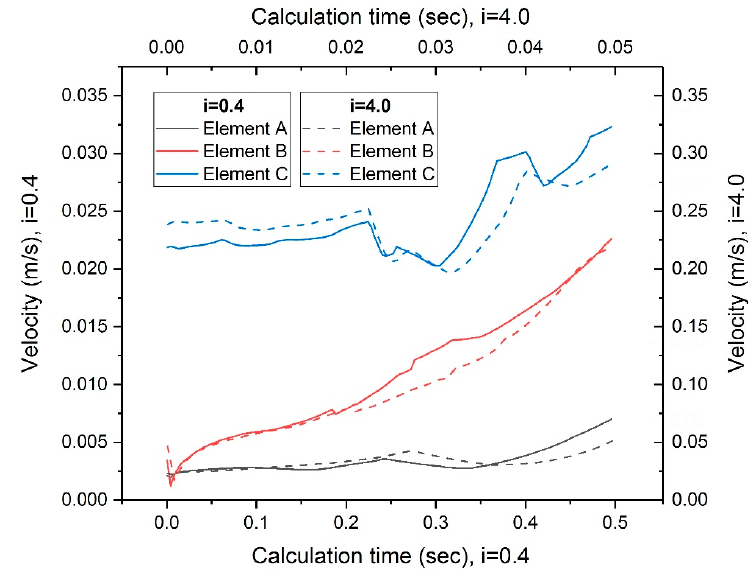
Figure 11. Seepage velocity of test model under different hydraulic gradients.